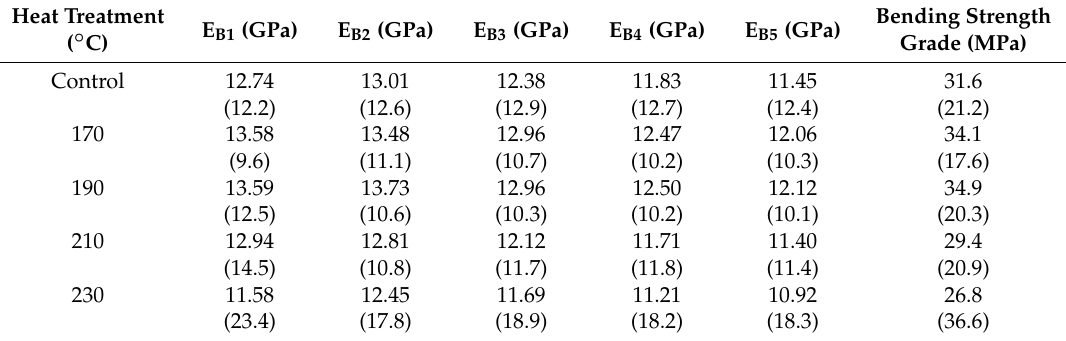
Table 3. Mean moduli of elasticity of heat-treated structural timber determined by flexural vibration at individual vibration mode (1 ≤ n ≤ 5) and its mean bending strength according to EN 338 (2nd row present Coef. of variation